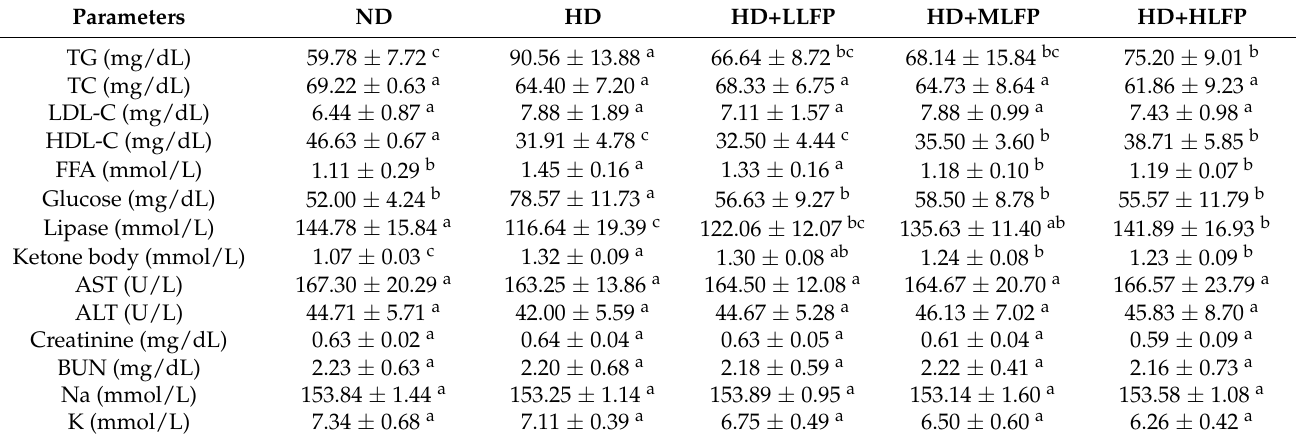
Table 2. Effect of LFP on serum biochemical parameters in rats fed a high-calorie